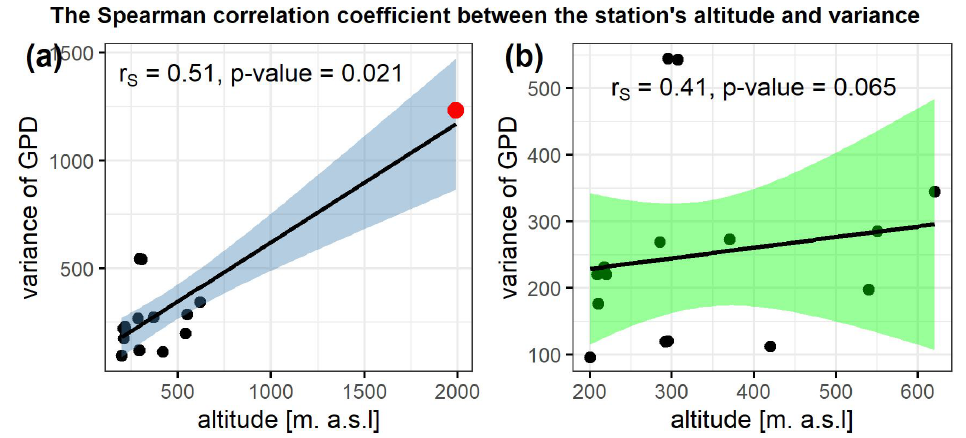
Figure 9. The scatterplot showing the relation between the station’s altitude and variance of the GPD. ( a ) Including the Kasprowy Wierch station marked in red. ( b ) Without the Kasprowy Wierch station. The blue or green area represents the confidence region around the regression line and its upper and lower bands are confidence limits of the predicted variance of rainfall depth at the confidence level of